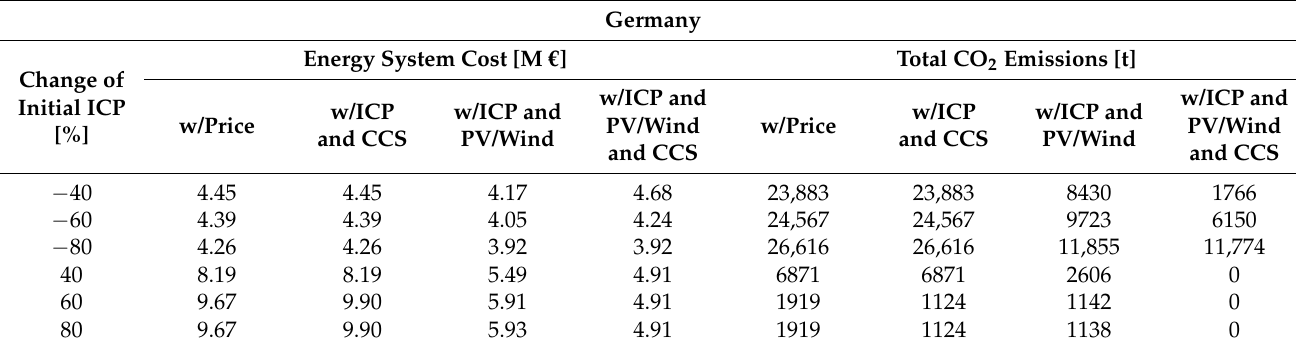
Table A1. Sensitivity analysis results for the German scenarios.